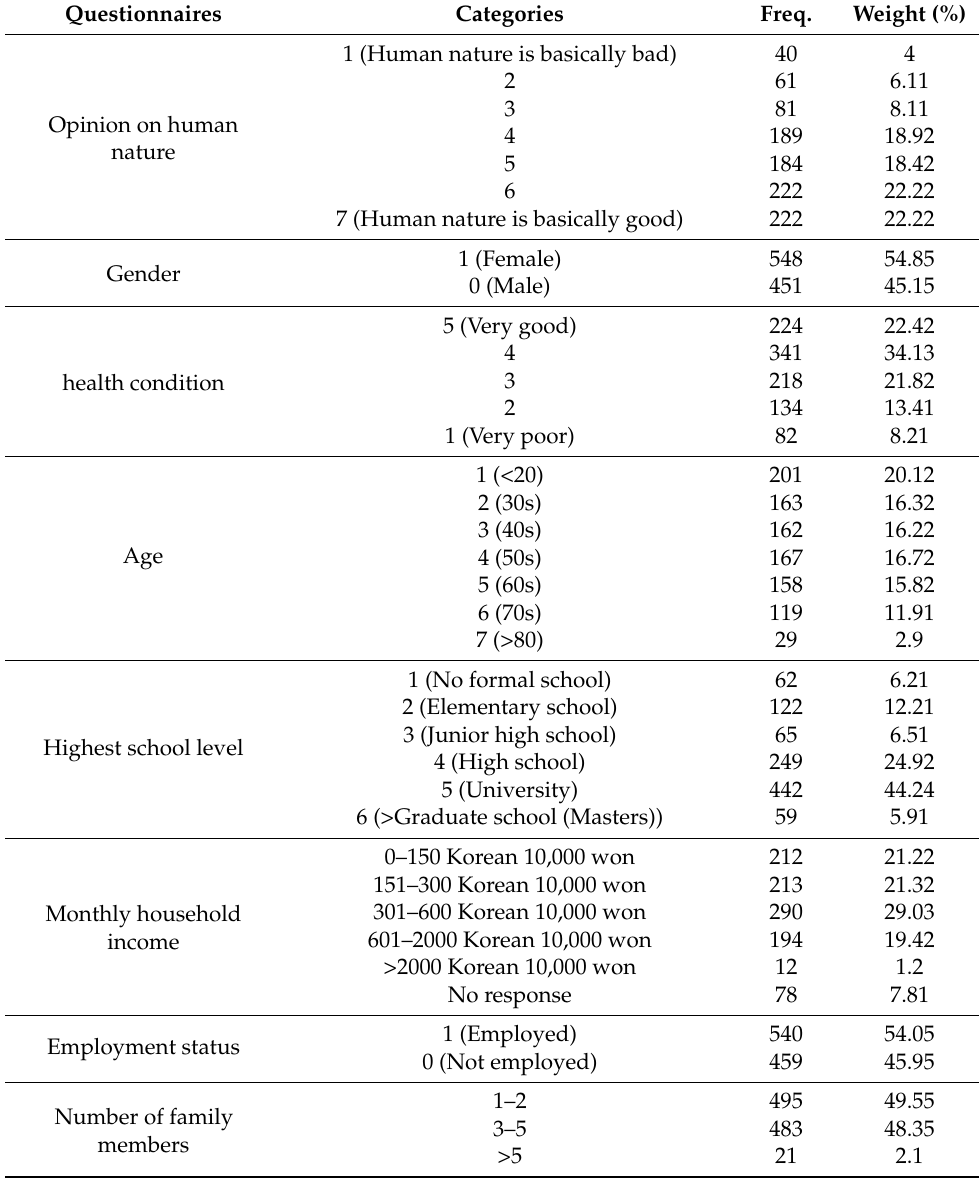
Table A1. Distribution of socio-personal questionnaires ( N =